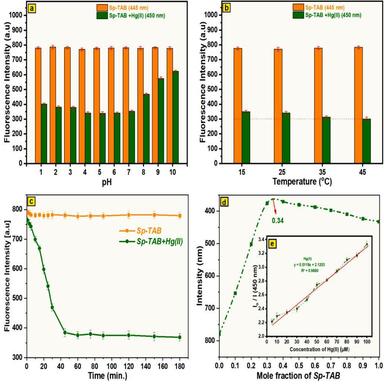
(a) Fluorescence intensity (445–450 nm) of Sp-TAB added to and excluding Hg(II) at various pH (4–11) values. (b) The changes in the fluorescence intensity at the range 445 nm and 450 nm of Sp-TAB and Sp-TAB + Hg(II) suspension mixtures at different temperatures (15–45 ◦C). (c) Fluorescence intensity (445–450 nm) of Sp-TAB added to and excluding Hg(II) as a function of time. (d) Job's plots for determination of the stoichiometry of formation of the Sp-TAB + Hg(II) complexes. (e) The linear calibration plots